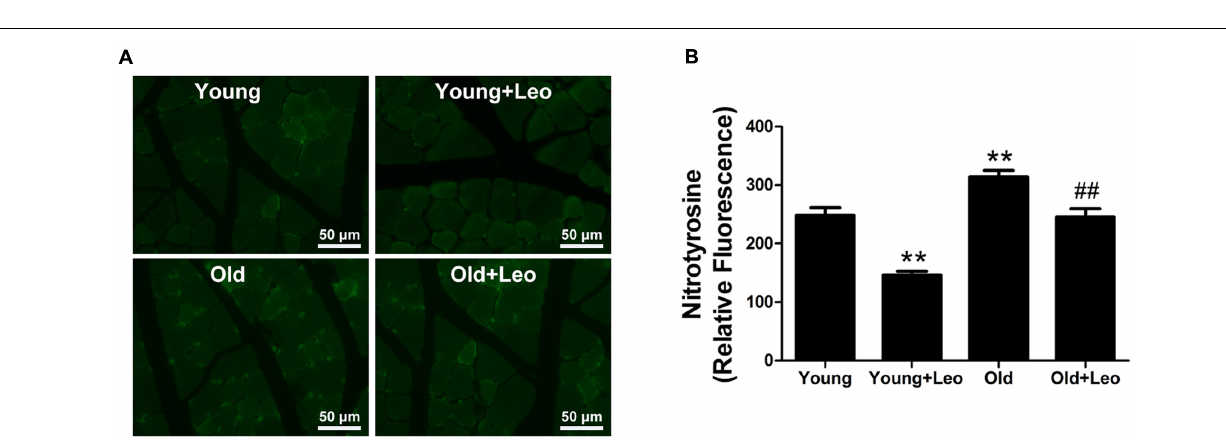
FIGURE 5 | Effects of leonurine on oxidative stress levels in ischemic muscles. (A) Representative photomicrographs of nitrotyrosine immunostaining in ischemic muscles harvested at day 14 after ischemia in the different groups. (B) Quantification of nitrotyrosine immunostaining in the ischemic muscles of mice from the different groups. Data are mean ± SEM. ∗∗ p < 0.01 vs. young group; ## p < 0.01 vs. old group. n = 6–8/group.